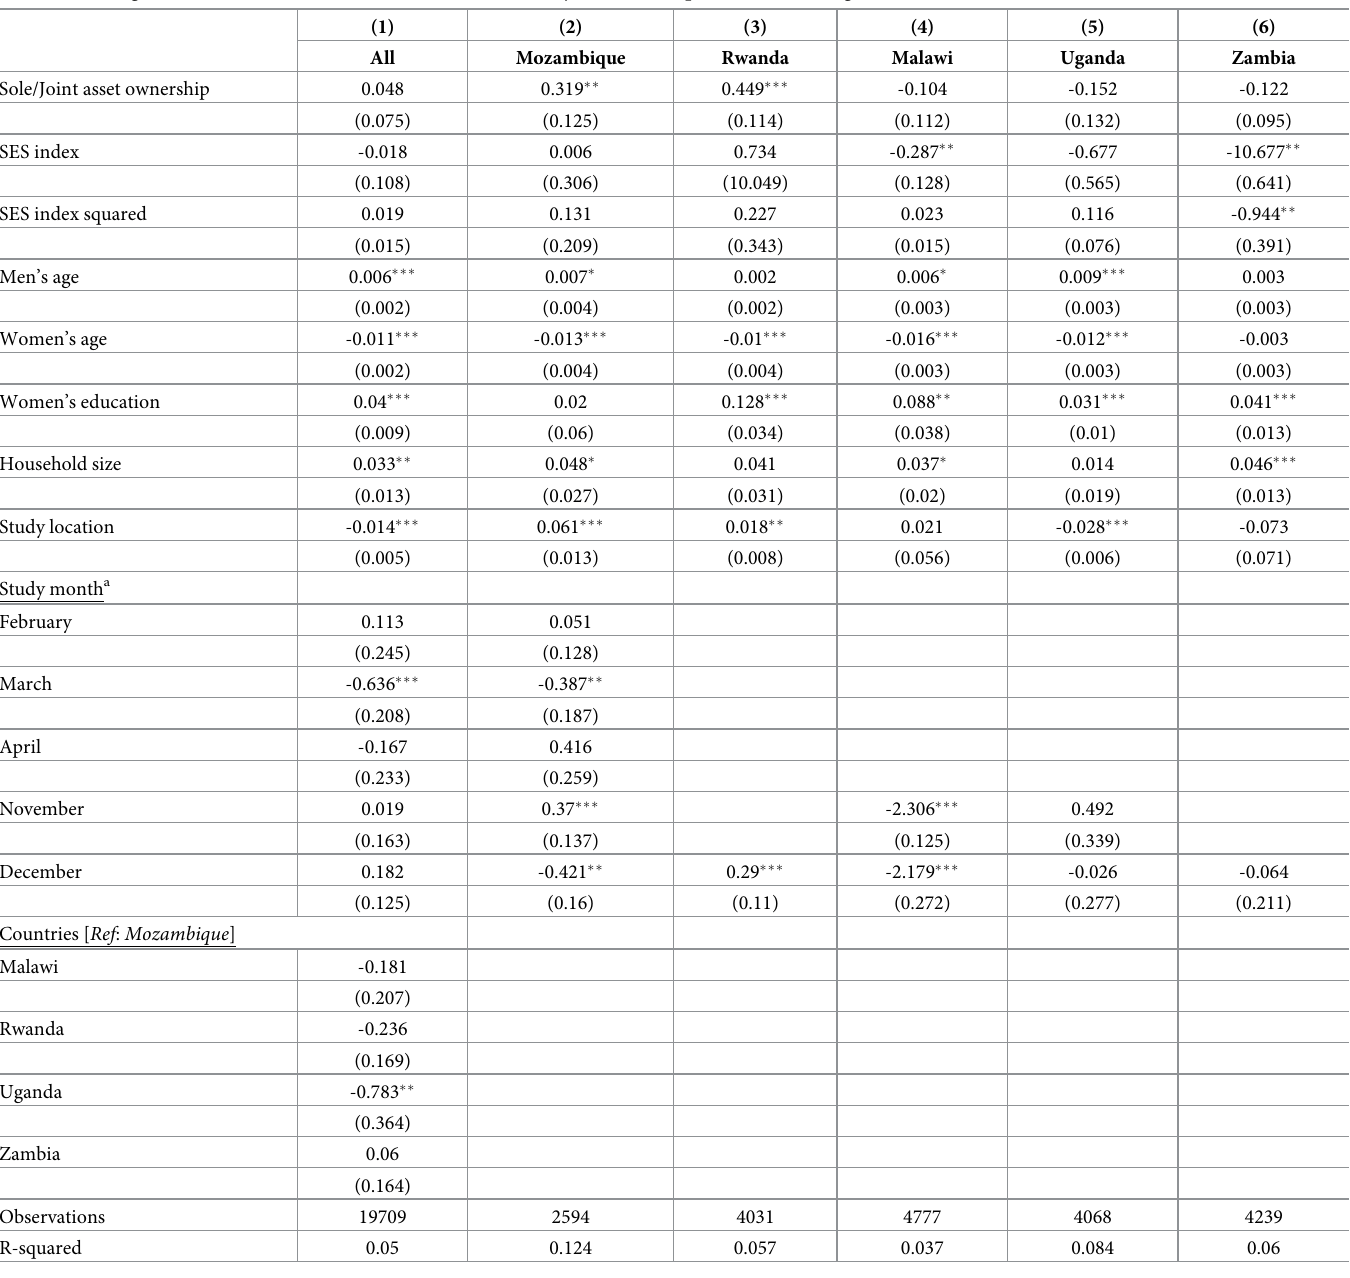
Table 7. OLS regression results for WDDS–resources domains (sole/joint ownership of � 2 small/1 large